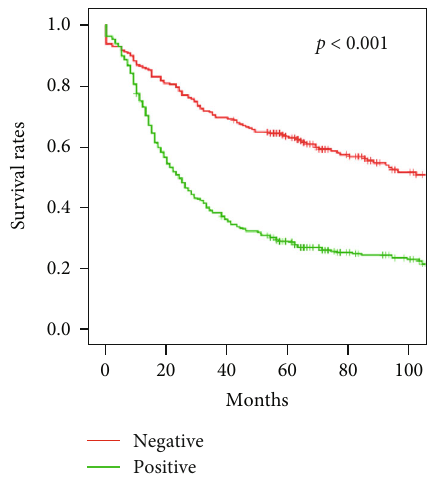
Figure 4: Survival of upper gastric cancer patients with and without lymph node metastasis, p < 0 : 001